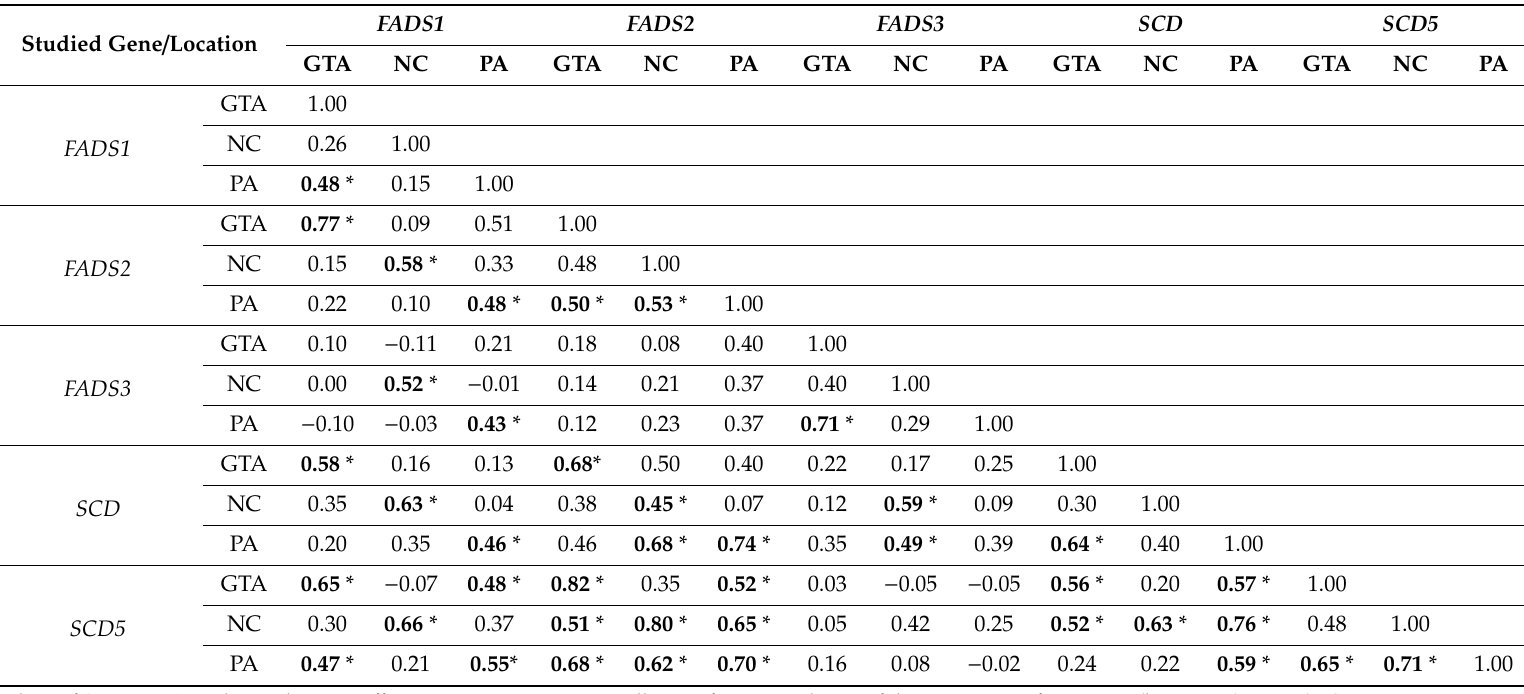
Table 3. Correlations between the mRNA expression of all studied desaturase genes in all three tumor zones, using B2M gene as reference. Studied Gene /